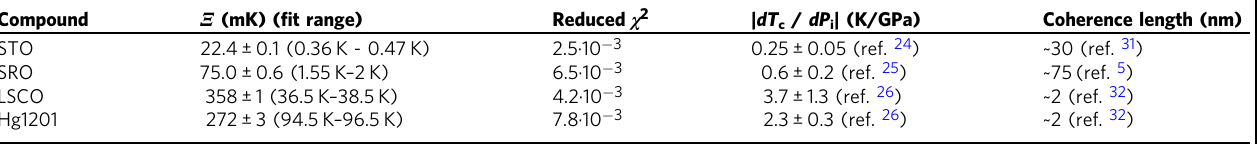
The sums of the squared residuals normalized to the number of experimental points (reduced χ 2 ) is given for linear fi ts to the scaled log M 3 curves (Fig. 2a) so as to be directly comparable. For SRO, LSCO, and Hg1201, the average in-plane values of the derivatives are used; the large error margin for LSCO re fl ects the fact that the two principal in-plane values differ by a factor of 2. For SRO, the dependence of T c on P a is strongly nonlinear, and we take the average slope between T c = 1.5K and T c = 2K by simply fi tting a linear function to data for two samples in ref.